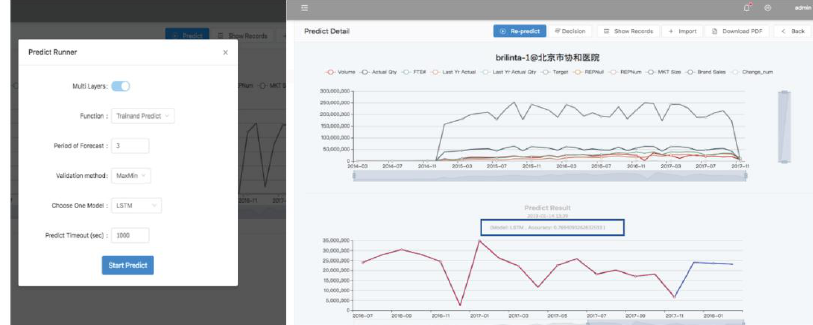
Figure A5. View of the Data Visualization Module. Here, we can show the data distribution and characteristics of the data by specifying the available time periods.